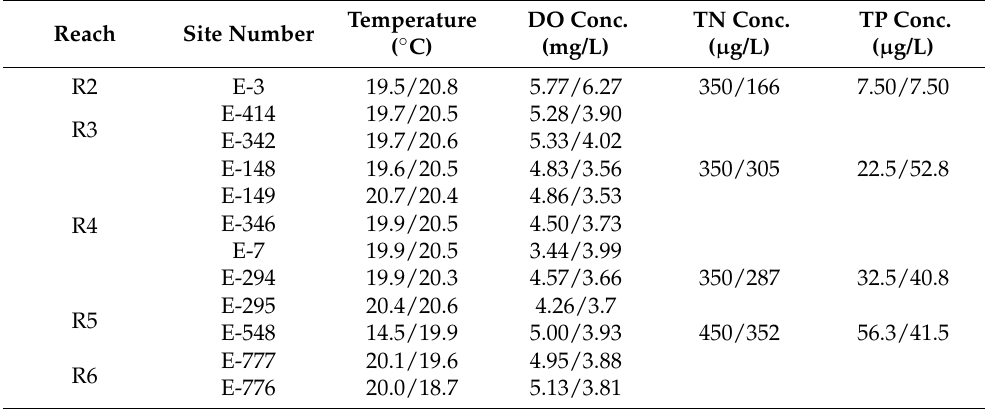
Table 2. Annual average water quality indicator values from the Shoalhaven River monitoring sites in